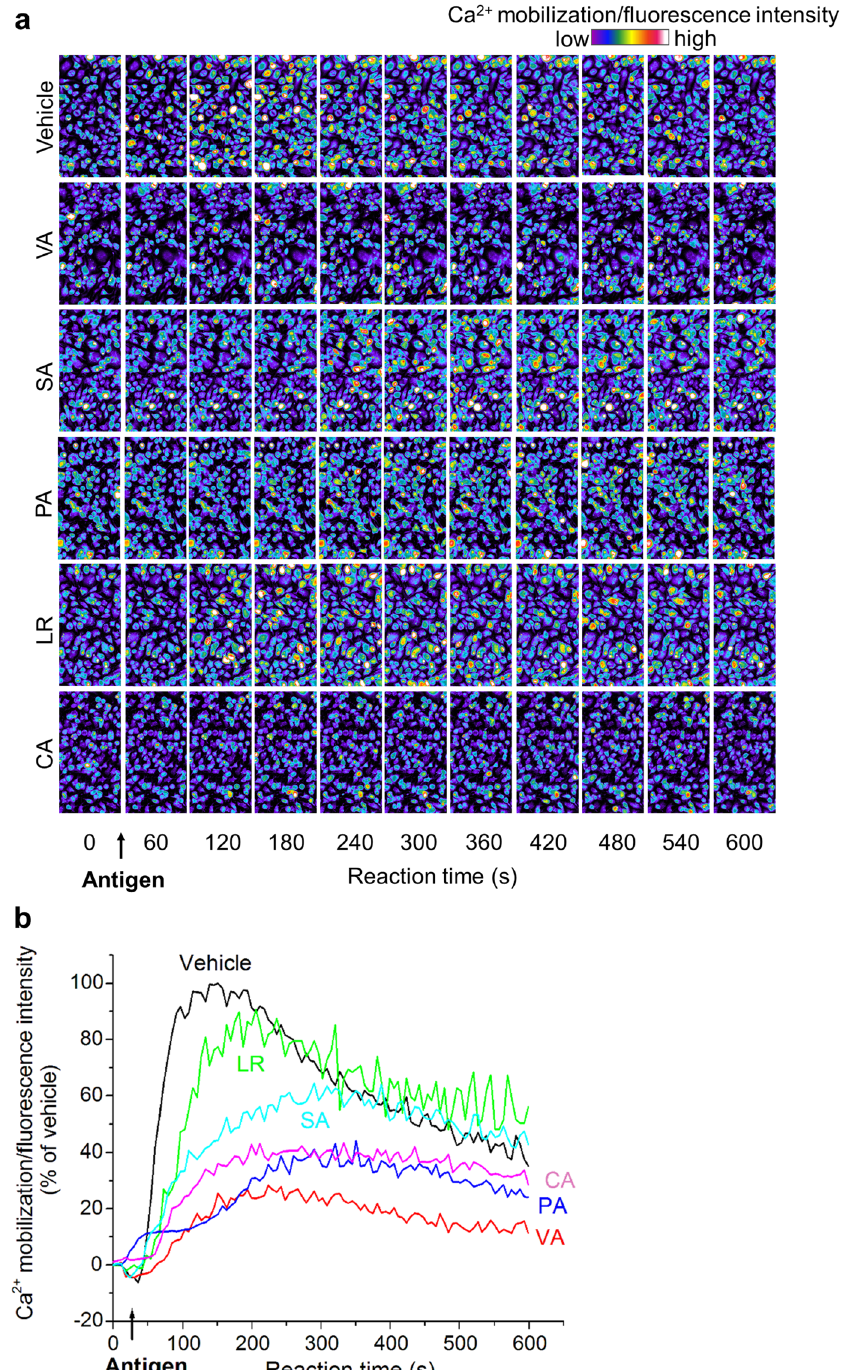
Figure 7. Effects of active compounds on intracellular Ca 2 + mobilization of IgE-sensitized RBL-2H3 cells induced by antigen. IgE-sensitized RBL-2H3 cells were stimulated with DNP-BSA in the presence of active compounds derived from ume seed at 600 μ M or vehicle (0.1% DMSO). ( a ) CLSM image shows the change in RBL-2H3 cells upon DNP-BSA stimulation. The crosswise direction indicates the reaction time of antigen stimulation. The bar represents fluorescence intensity from low (purple) to high (red). Scale bar: 20 µ m. ( b ) Antigen-induced intracellular Ca 2 + mobilization monitored by CLSM. The mean fluorescence intensities of the scan area were estimated from CLSM images. Arrow indicates antigen-stimulated time points. Results are representative of three independent experiments with similar